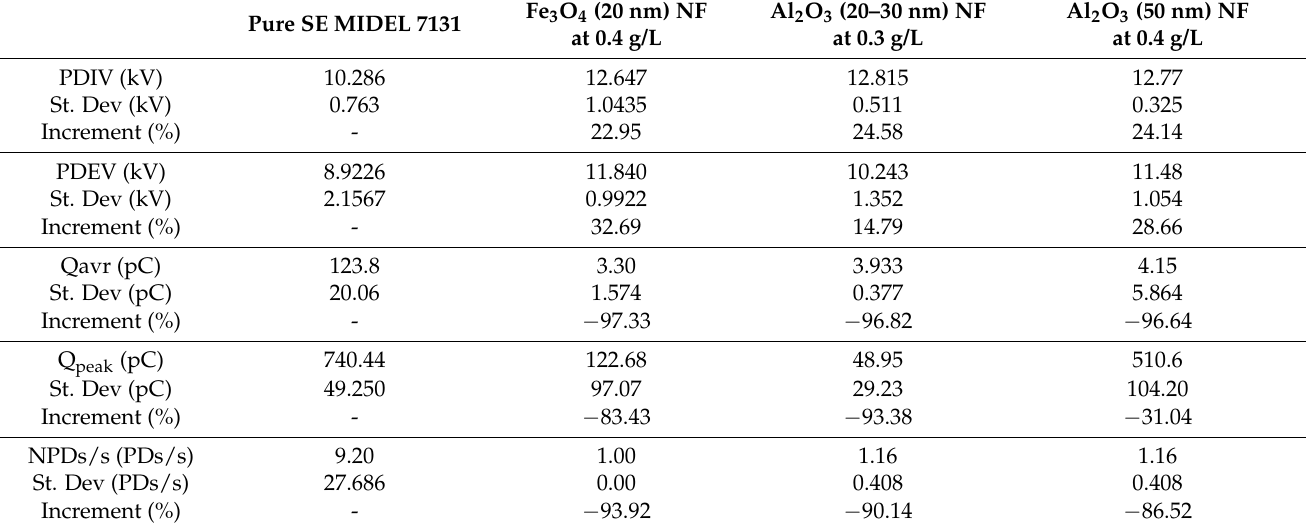
Table 8. PD activity of synthetic ester and synthetic ester-based nanofluids with Fe 3 O 4 (20 nm) and Al 2 O 3 (20–30 and 50 nm).